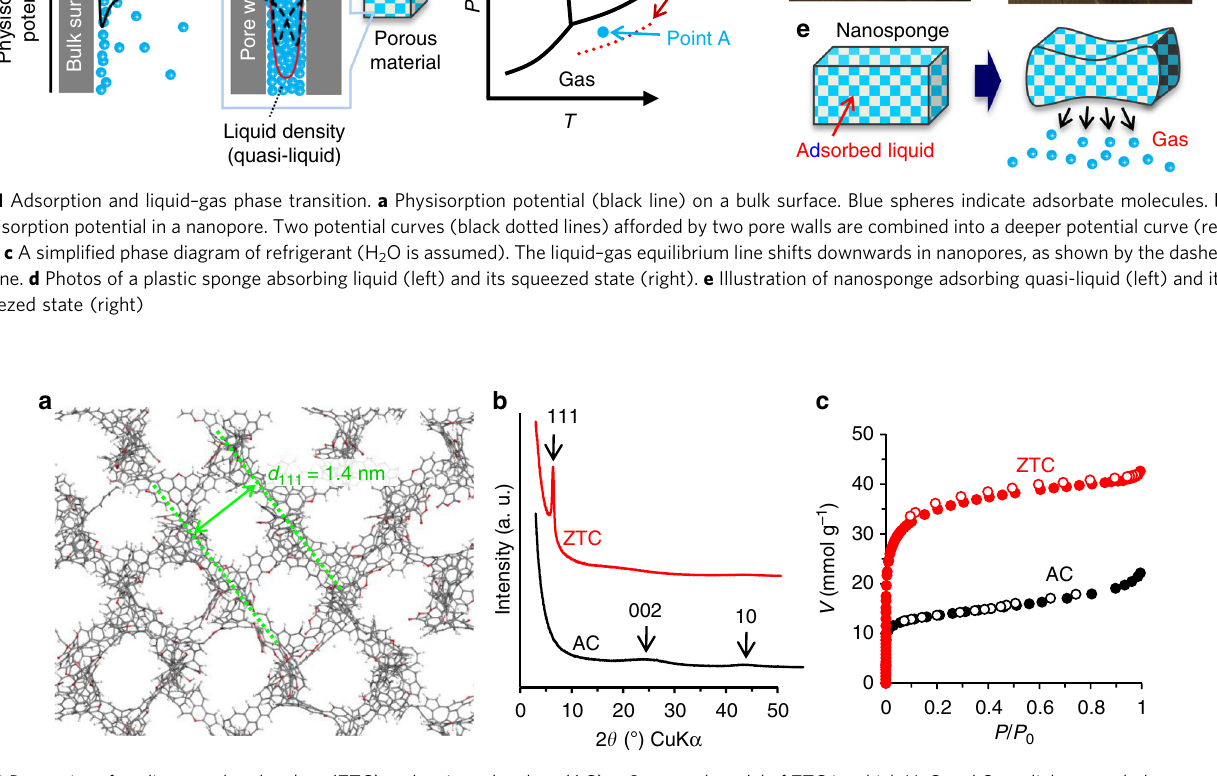
Fig. 2 Properties of zeolite-templated carbon (ZTC) and activated carbon (AC). a Structural model of ZTC in which H, C and O are light grey, dark grey and red spheres, respectively. This model is constructed using the previously developed method 27 . b XRD patterns of ZTC (red line) and AC (black line). c N 2 adsorption – desorption isotherms of ZTC (red symbols) and AC (black symbols) measured at 77 K. Solid and blank symbols correspond to adsorption and